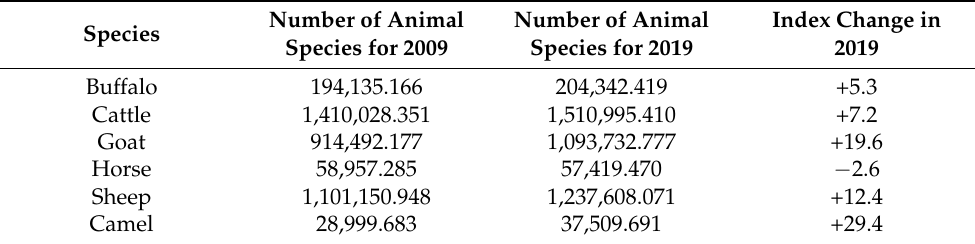
Table 5. Livestock population growth between 2009 and 2019 (index 100 in 2009) (source: FAOstat, 2021. Available online: www.fao.org (accessed on 26 May